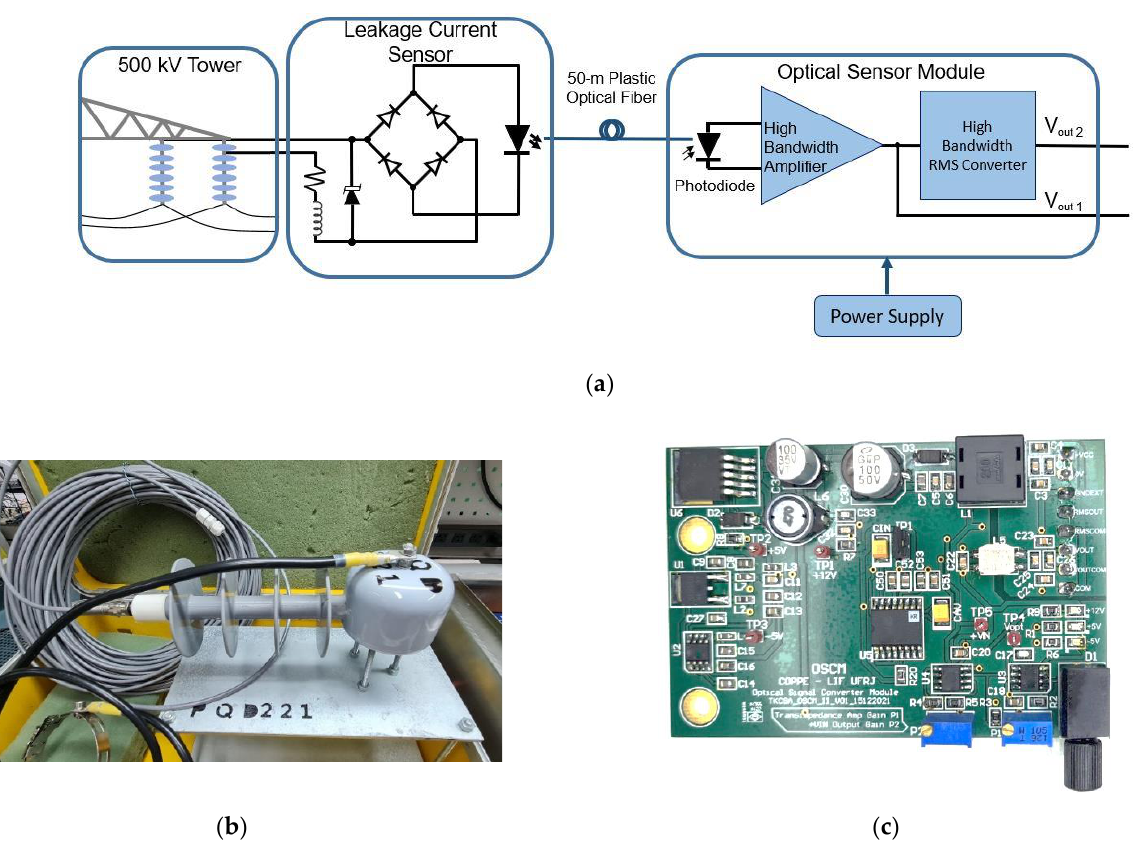
Figure 1. ( a ) Block diagram of the leakage current sensor and optical sensor module; ( b ) a sensor inside an IP66-rated enclosure, with the POF (plastic optical fiber) cable and the electric electrode; ( c ) PCB of the optical receiver.